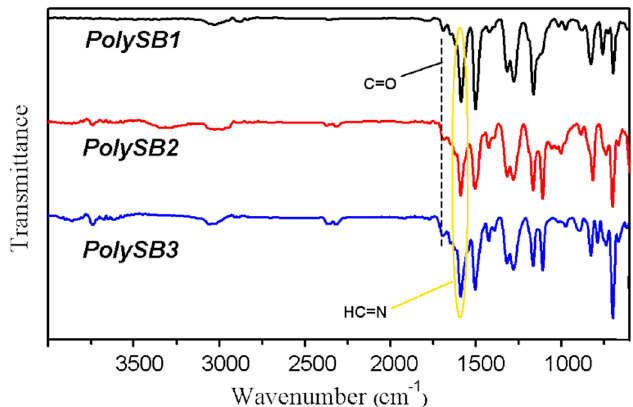
Figure 2. ATR/FT-IR spectra of polySBs.